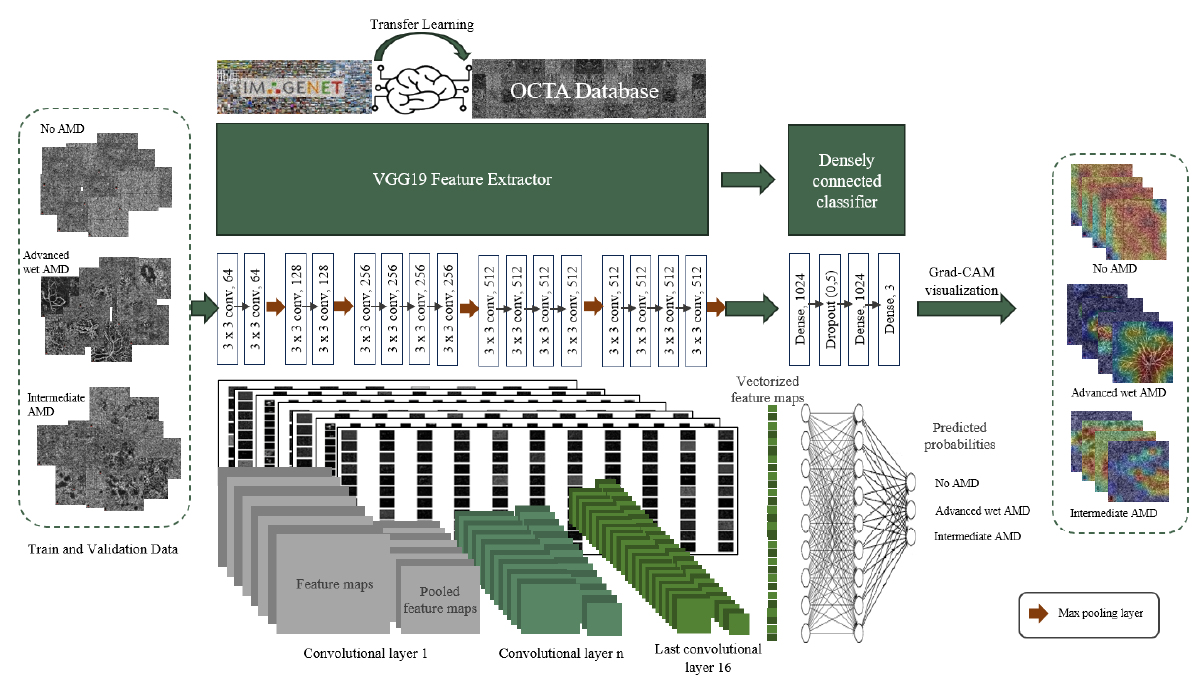
Figure 2. Our proposed modified VGG19 architecture. OCTA images are mapped through the VGG19 feature extractor to build discriminant 9 × 9 feature maps that are used by the densely connected classifier to generate predicted probabilities and Grad-CAM heatmaps to visualize feature attribution for each class: No AMD (healthy choriocapillaris), advanced wet AMD (CNV), intermediate AMD (drusen/choriocapillaris impairment).